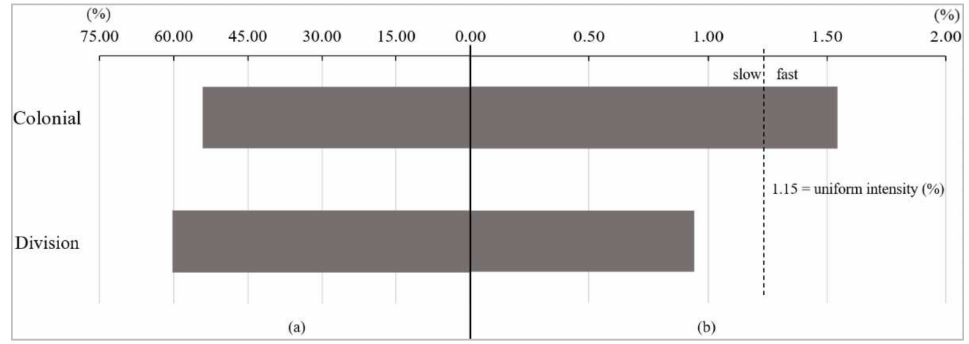
Figure 6. Interval level rates of change: ( a ) rate of change in each period and ( b ) annual rate of change (i.e.,